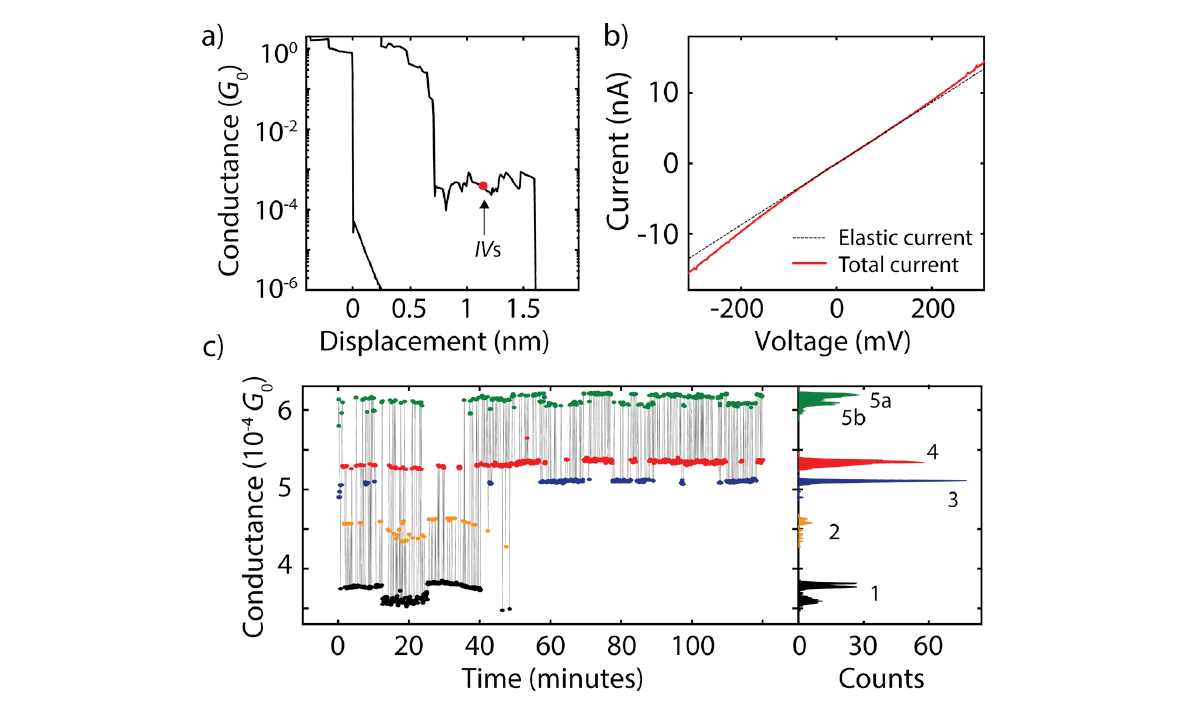
Figure 2: (a) Typical breaking traces recorded on a junction without molecule (left) and with OPE3 (right). (b) IV recorded at the location indicated by a red dot along the OPE3 plateau in (a). The dashed line represents the elastic contribution obtained from a linear fit at low-bias. (c) Low-bias conduc- tance for the 1200 consecutive IV s recorded at the location indicated by a red dot along the OPE3 plateau in (a). The colors used in (c) correspond to the different junction configurations